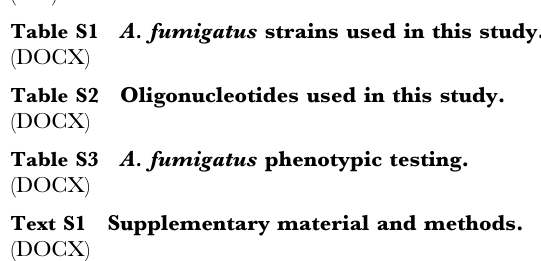
Figure S13 Immunofluorescence-mediated imaging of Table S1 A. fumigatus strains used in this study. Table S2 Oligonucleotides used in this study. Table S3 A. fumigatus phenotypic